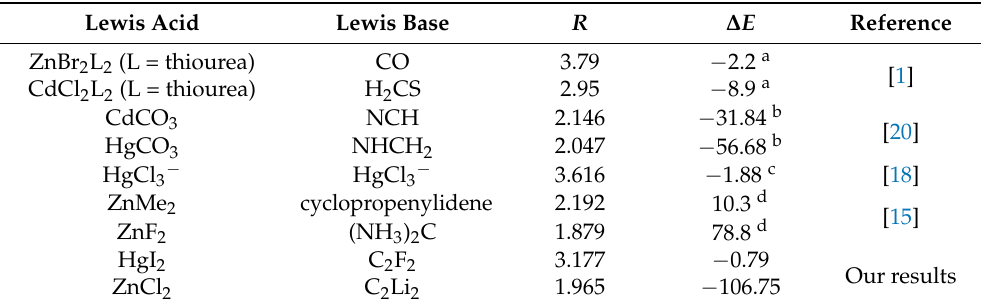
Table 6. Binding distance ( R in Å) and interaction energy ( ∆ E in kcal/mol) for some typical examples of spodium bonds. Lewis